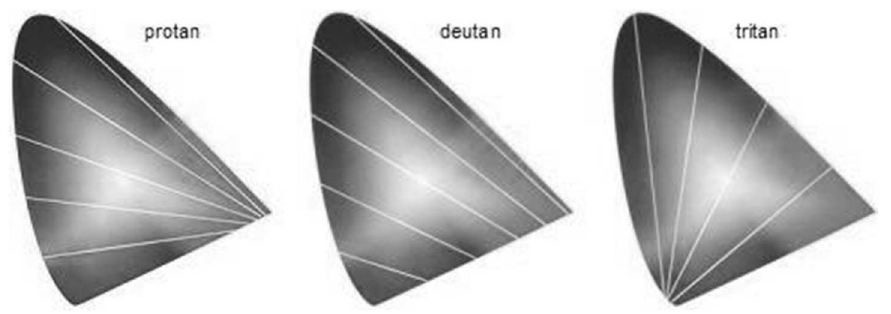
Figure 2. Schematic representation of the CIE color triangle with confusion lines for protan, deutan, and tritan defects (source: Opticaldiagnosti cscom, 2015)